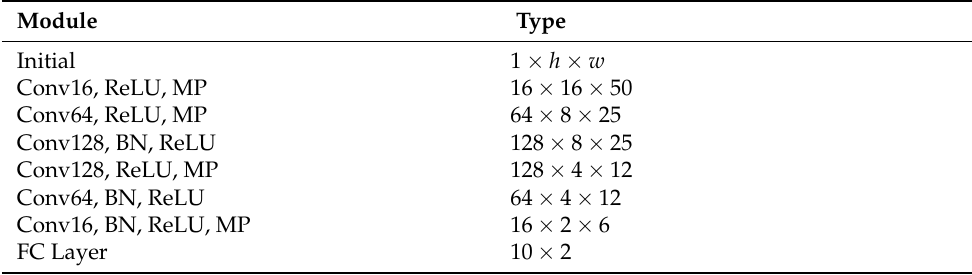
Table 1. Architecture of the Parameter Agent